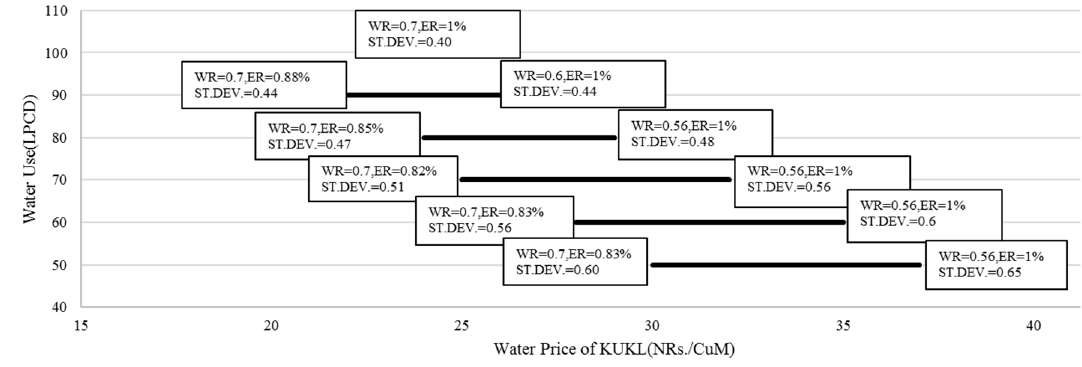
Figure 6. ER, WR, and standard deviation of threshold values and acceptable water price range which satisfy (WR < 0.7, ER < 1%).